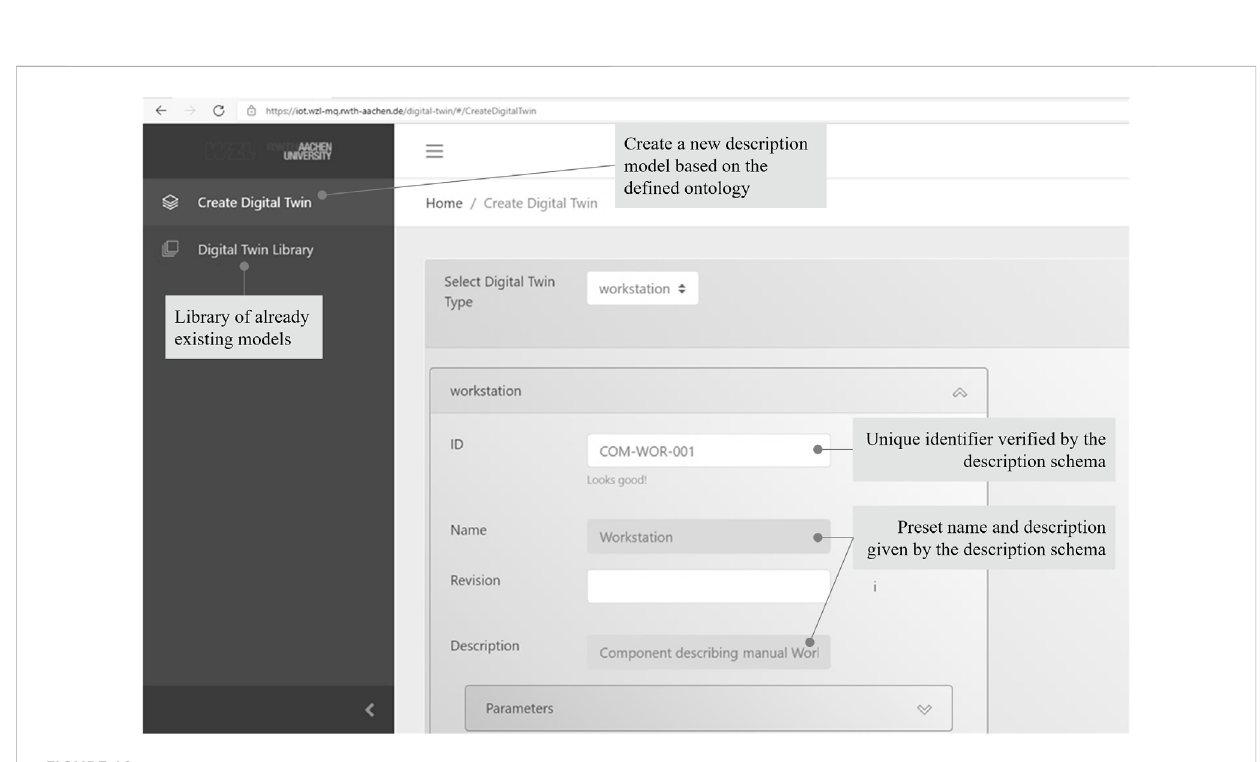
FIGURE 10 Web-based user interface of the model generator for new